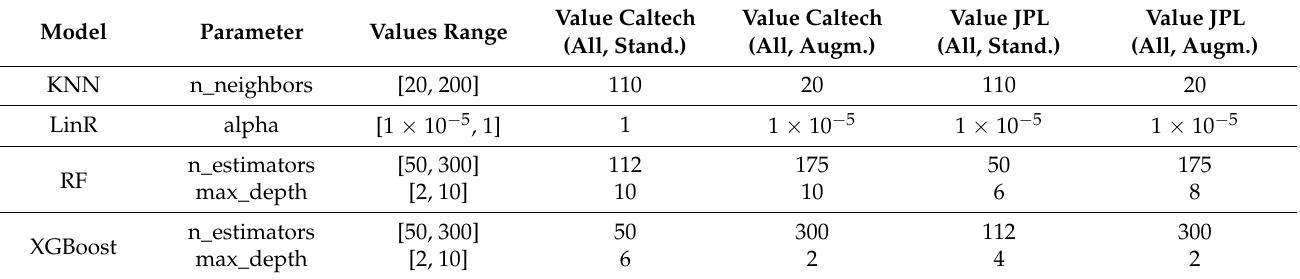
Table 5. Overview of regression hyperparameters used for grid search.